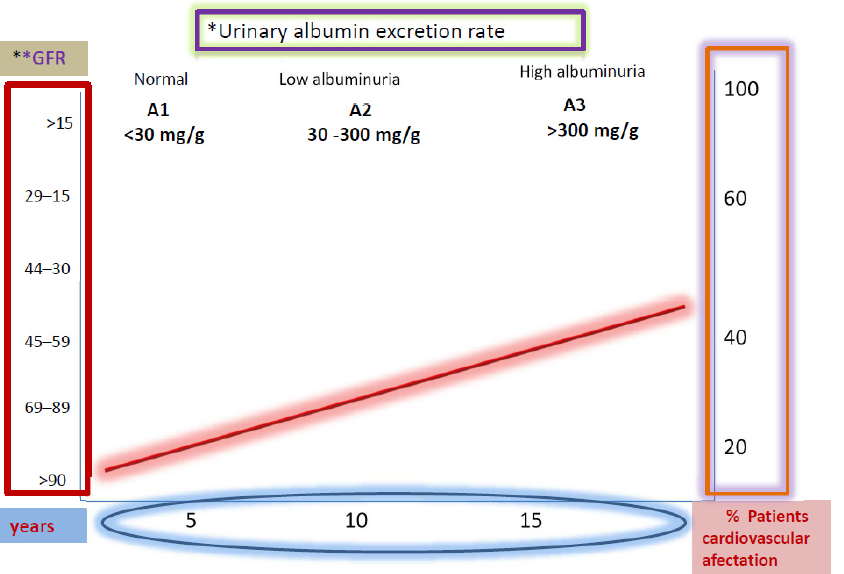
Figure 2. Correlation between renal function deterioration and degree of diabetic nephropathy.